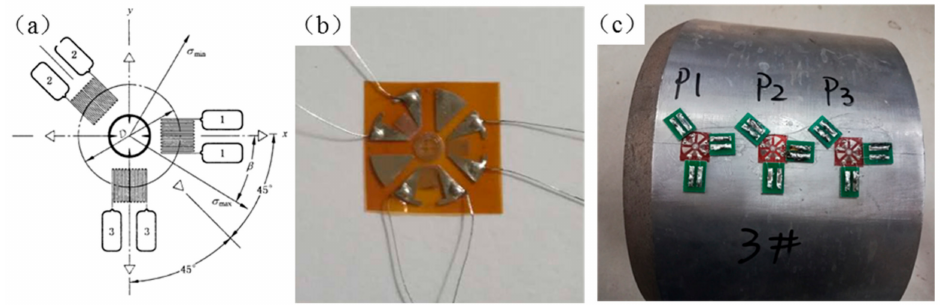
Figure 4. Strain gauge rosette type A: ( a ) Schematic; ( b ) TJ120-1.5-Ø1.5; and ( c ) residual stress